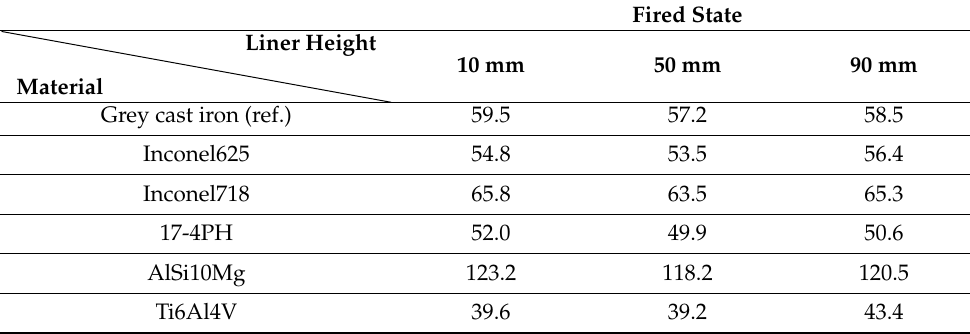
Table 3. Roundness deviation of the liner in µ